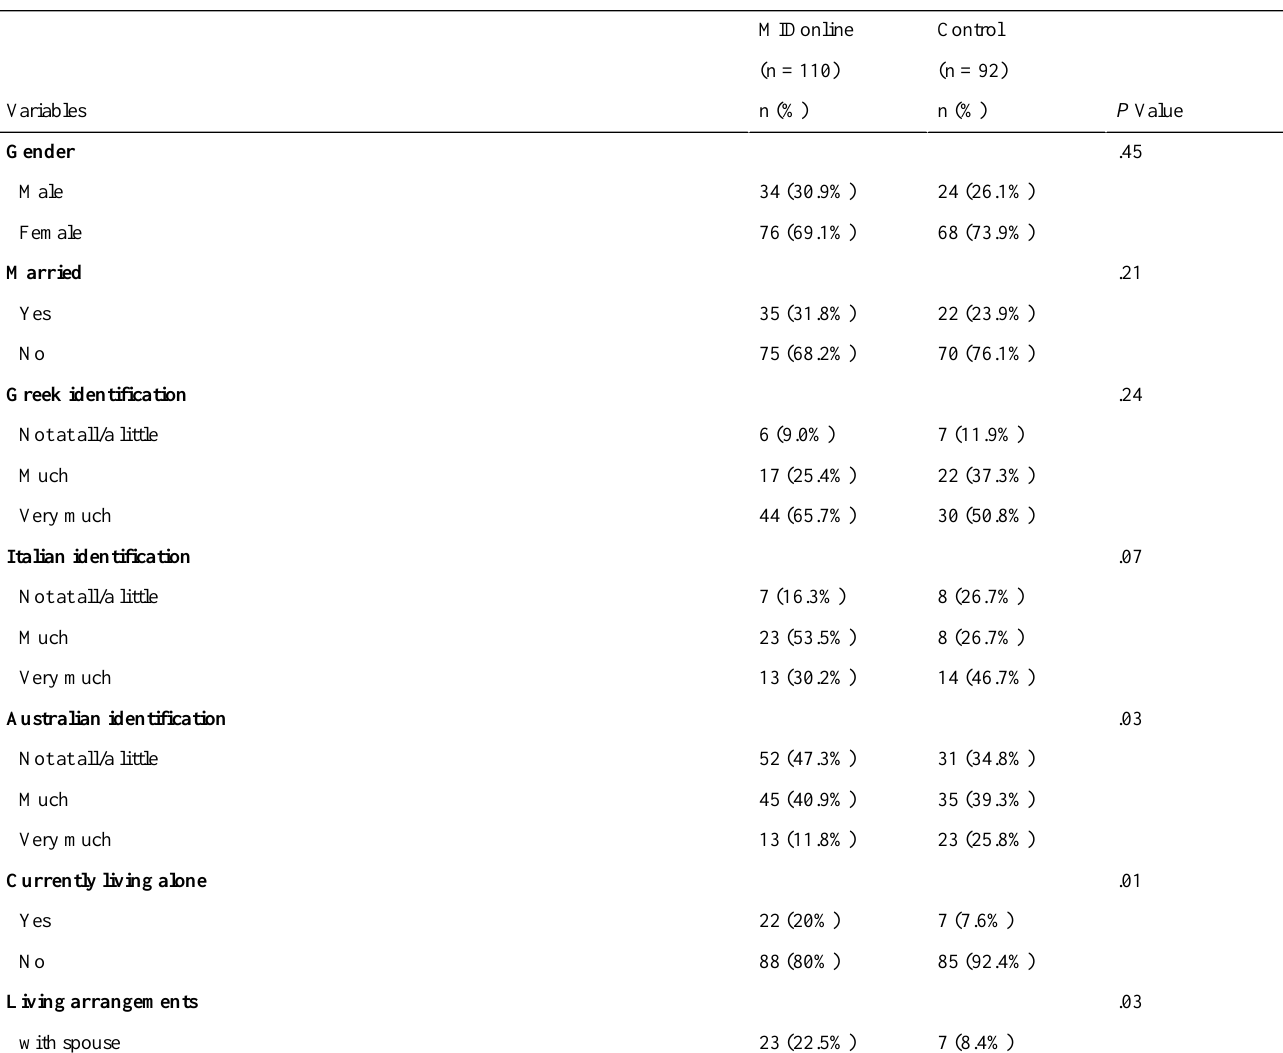
Table 1. Demographic characteristics of respondents for the MIDonline and control intervention